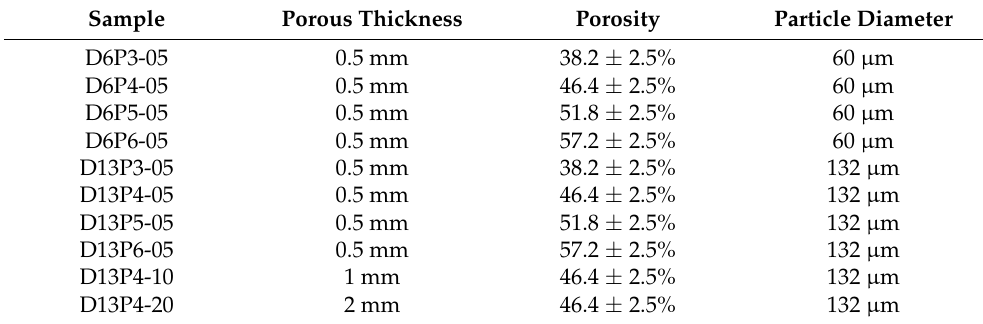
Table 1. Experimental sample